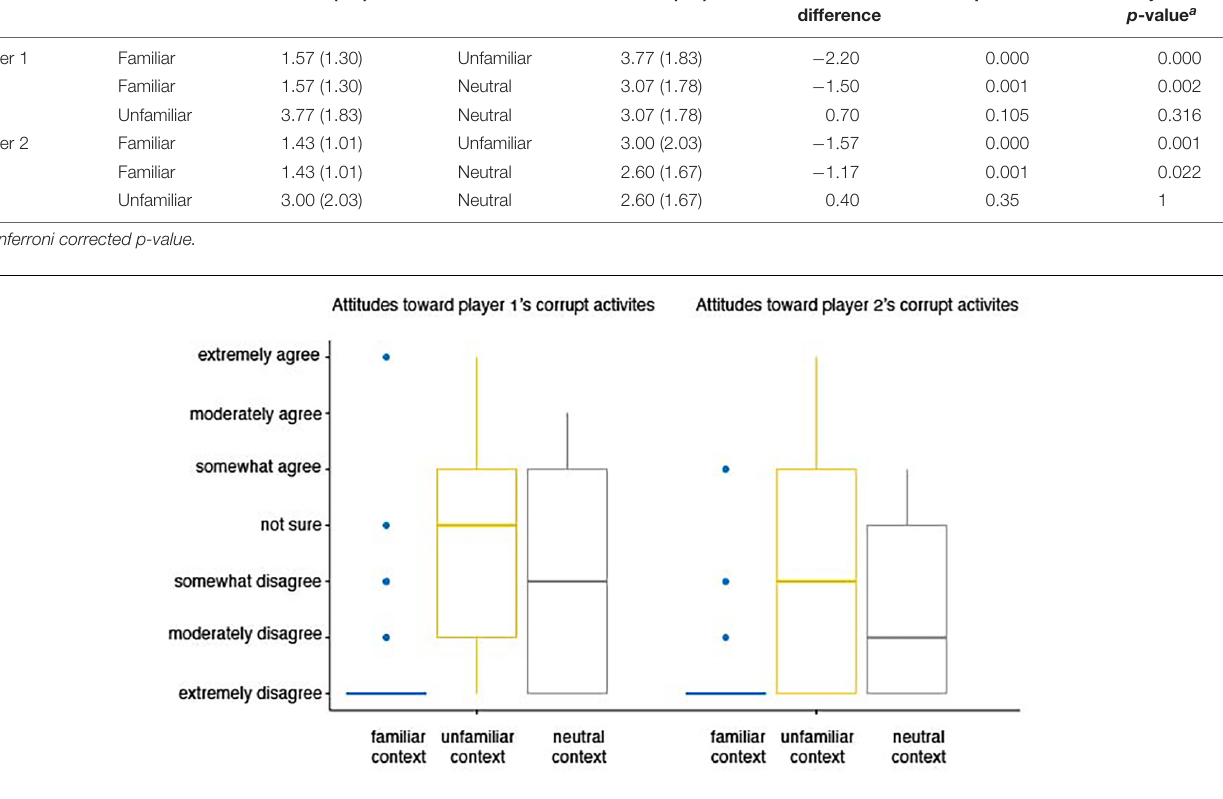
FIGURE 3 | Results of the attitude